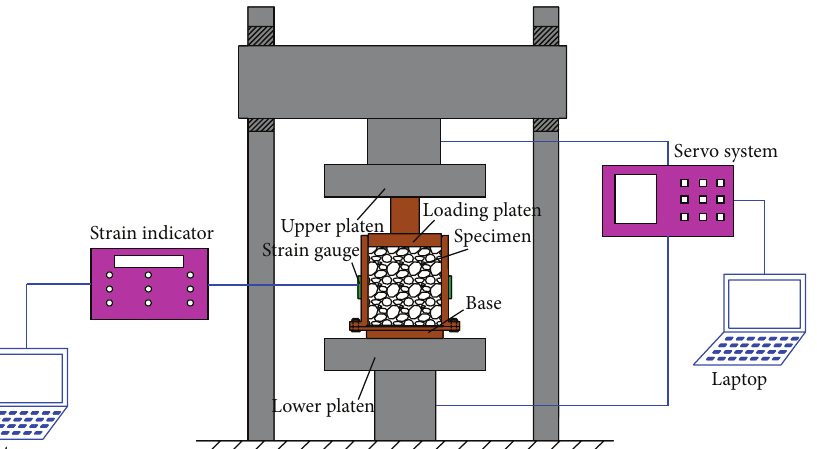
Figure 1: Basic principle of solid backfill mining.